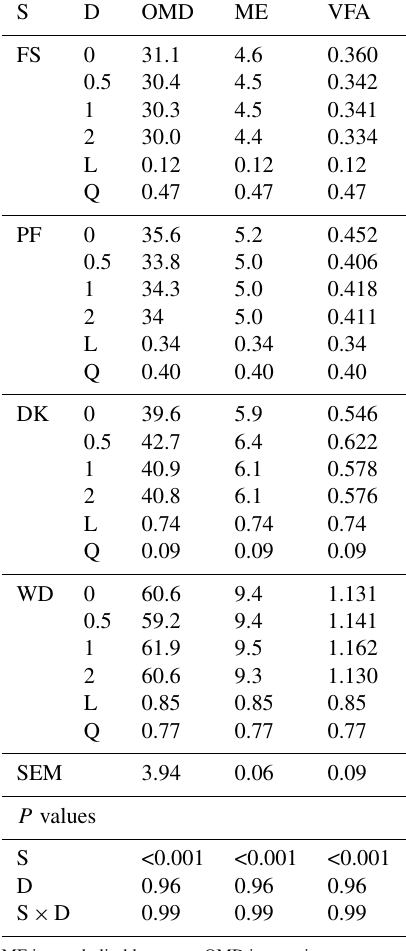
Table 4. Effect of increasing the dose of EFE (mg(gDM) − 1 ) on in vitro rumen fermentation profiles of date palm